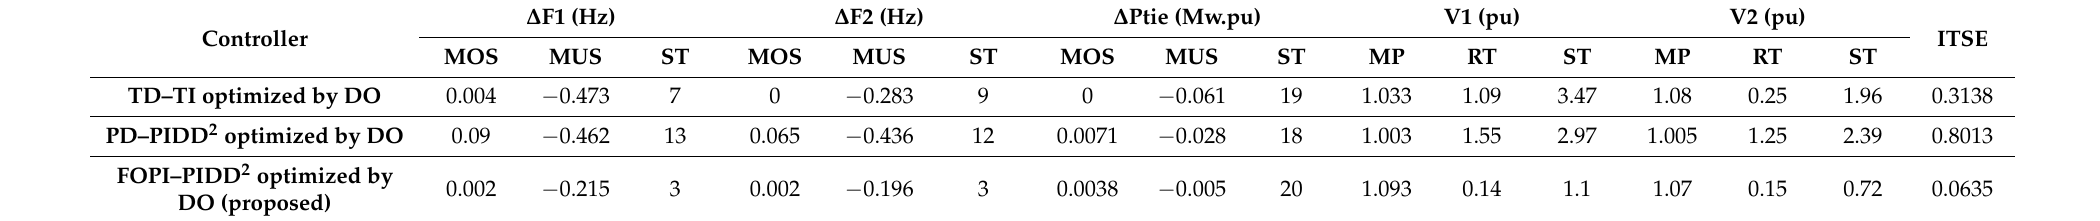
Table 10. Dynamic specifications of the investigated system using different controllers under scenario 7